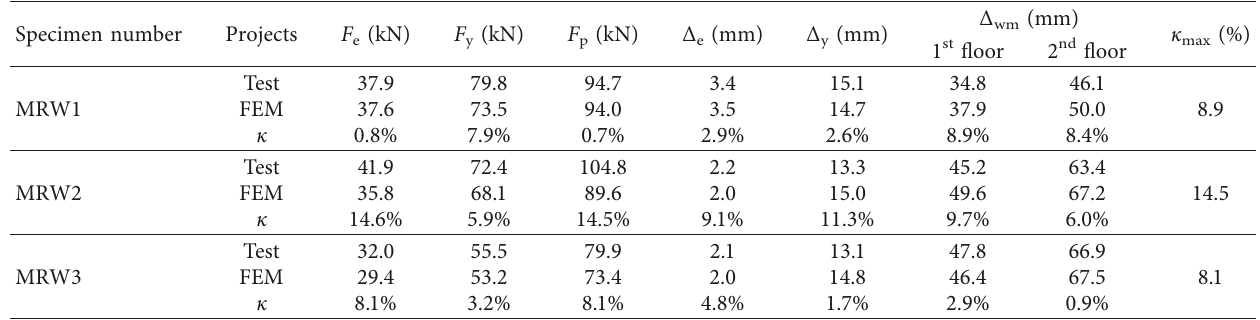
Figure 7: Numerical model of specimen MRW1. (a) Numerical model of mid-rise RCFS shear walls. (b) Detailed constraints of adjacent shear walls. Table 6: Comparisons between the simulated and test results